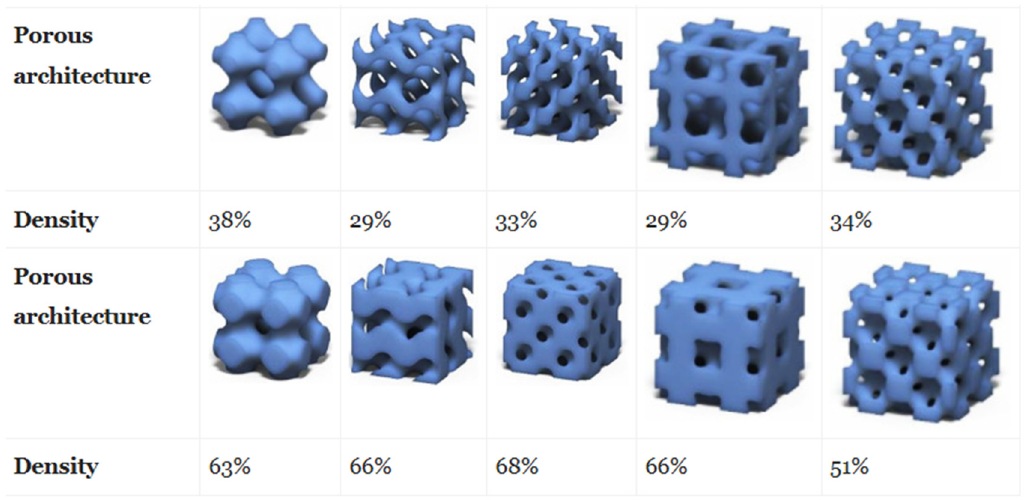
Figure 4. Examples of unit cell design with triply periodic minimal structures (TPMS) with various relative densities ( ρ s / ρ b ) as potential sca ff olds for tissue engineering. Adapted with permission from Montazerian et al. [137].